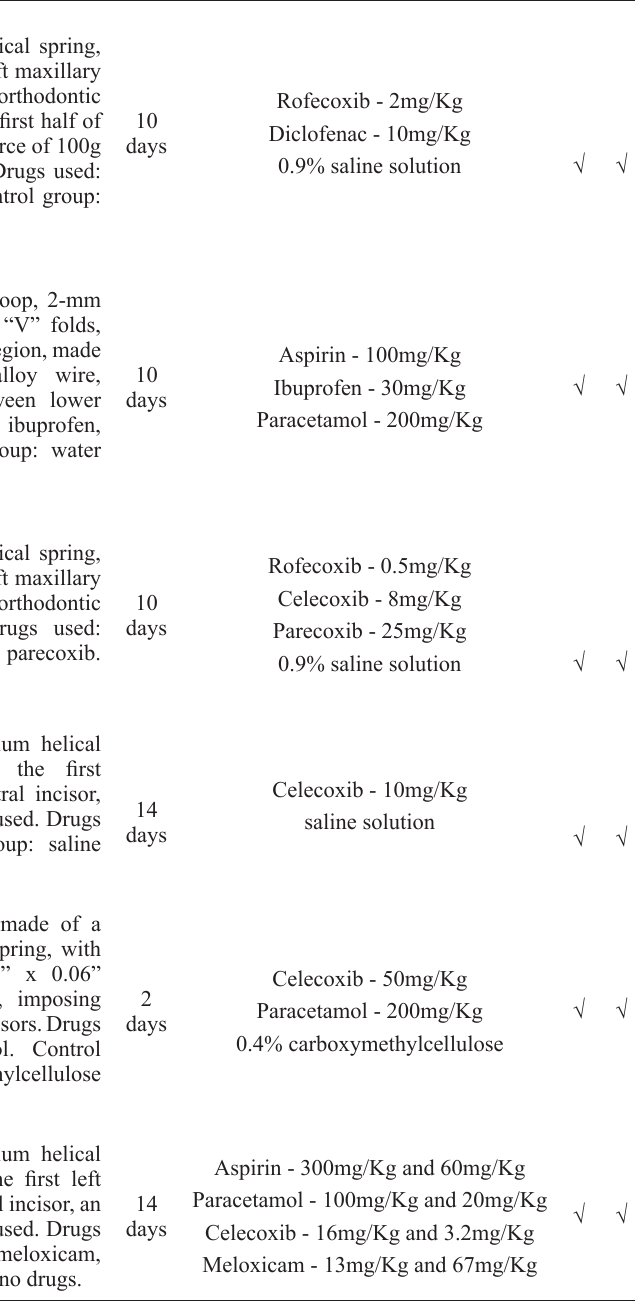
Interventions used to assess the influence of NSAIDs on orthodontic movement according to PICO strategy. Studies